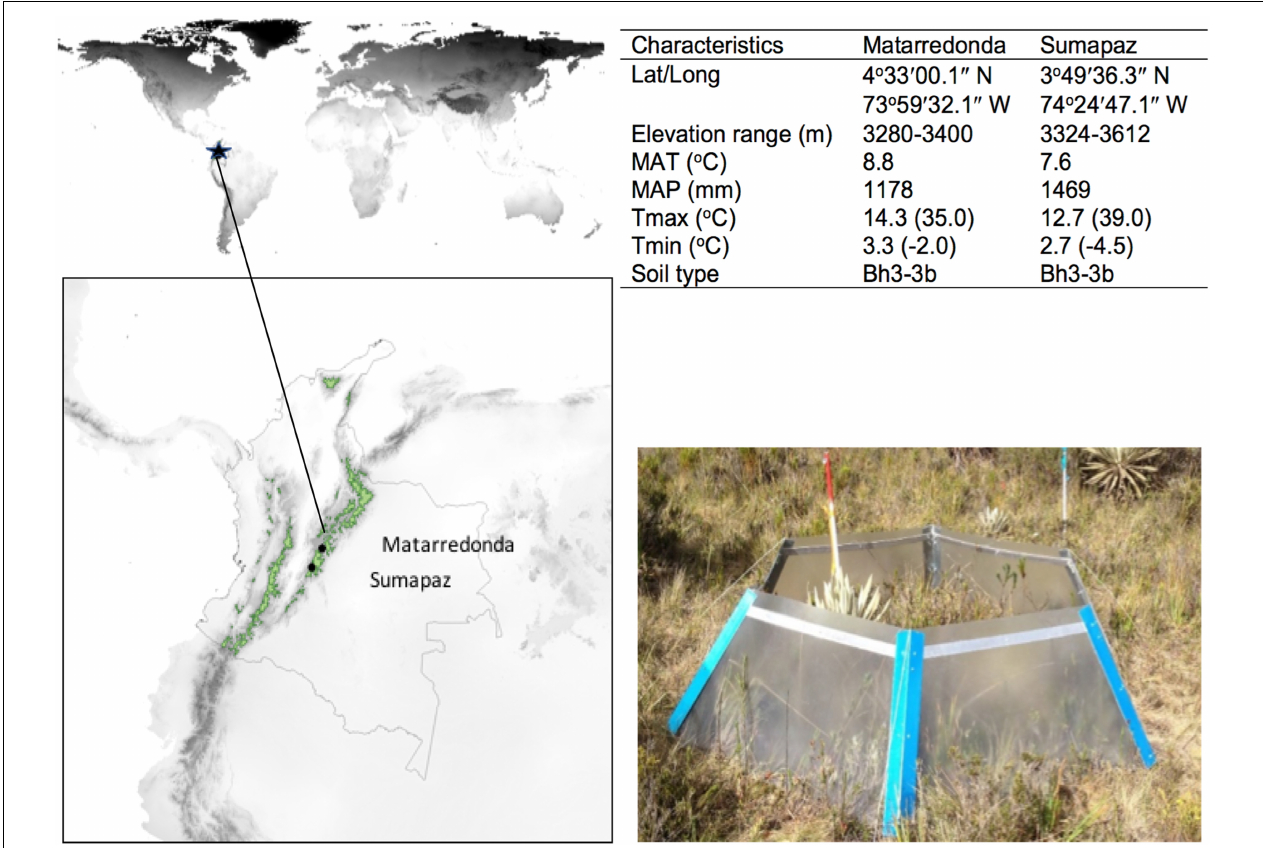
FIGURE 1 | Location, characteristics of the study sites and OTC design. Páramos of Colombia are depicted in green. Climatic variables were downloaded from http://www.worldclim.org/bioclim and the maximum and minimum temperatures registered by our temperature sensors during 2017–2019 are shown in parenthesis.